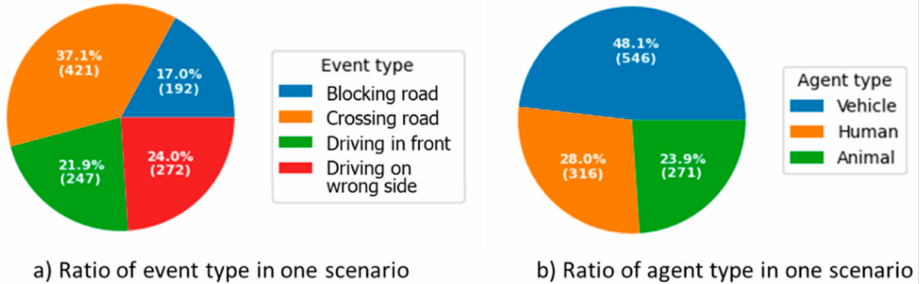
Figure 21. Ratio of event type and agent type in scenario shown in Figure